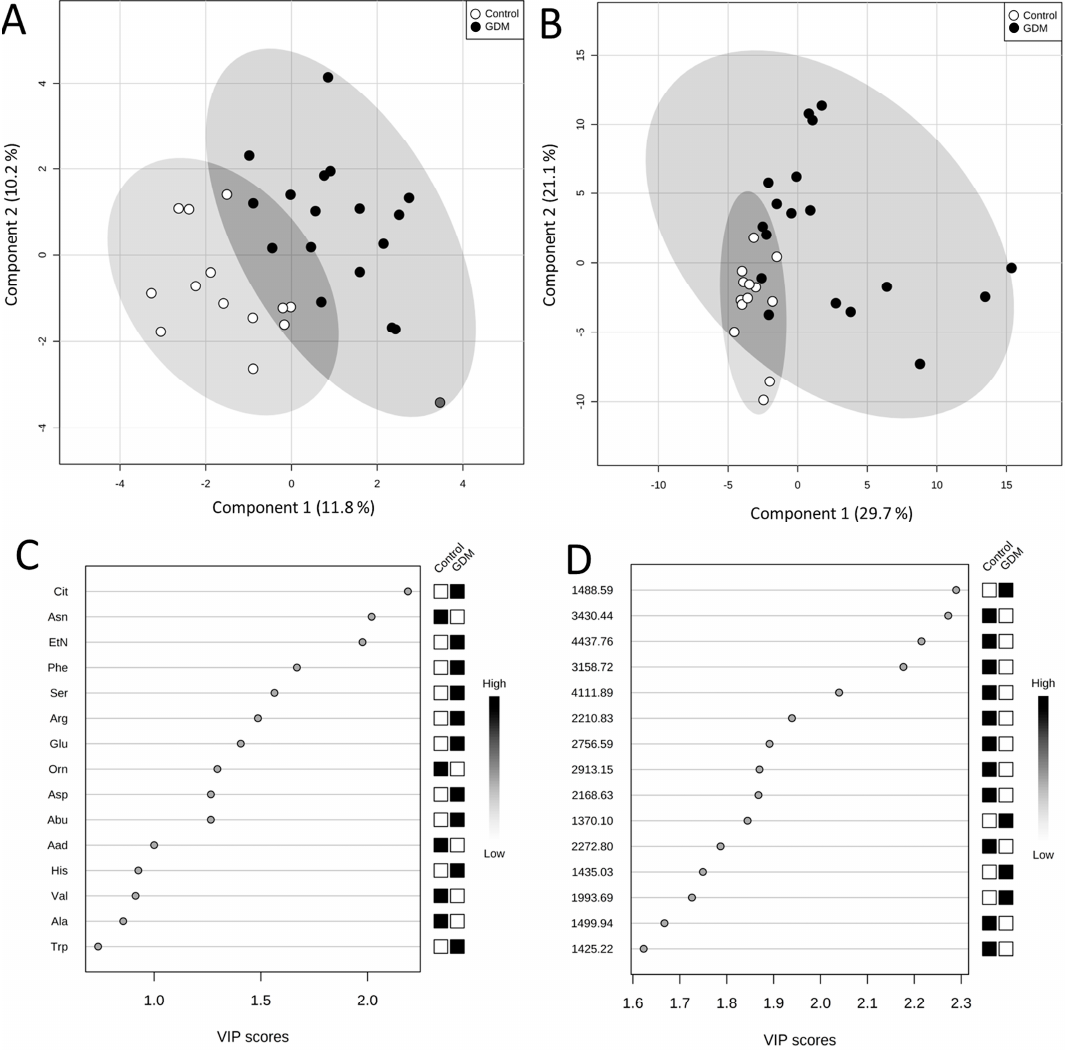
Figure 1. Score plots between first and second latent variable obtained in PLS-DA using plasma free amino acid concentrations ( A ) and peptide ion peak intensities; ( B ) Important variables; ( C ) plasma free amino acids; ( D ) peptide ions identified by PLS-DA.